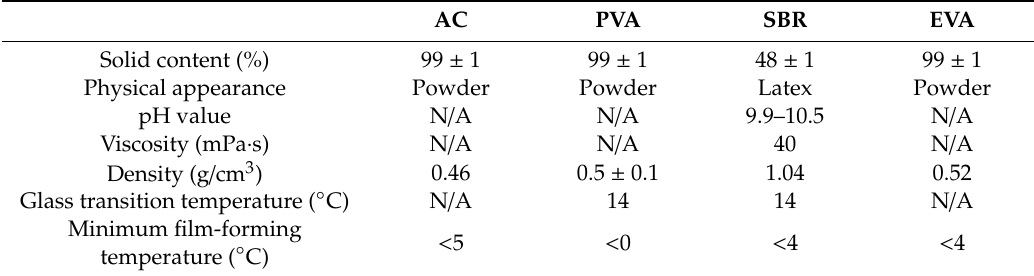
Table 3. Properties of selected polymers (N / A—not available; AC—acrylate polymer; PVA—polyvinyl alcohol; SBR—styrene–butadiene rubber; EVA—ethylene-vinyl acetate).